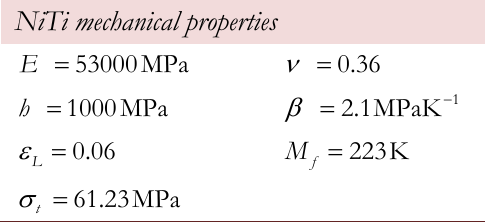
Table 1: Material properties for the porous NiTI